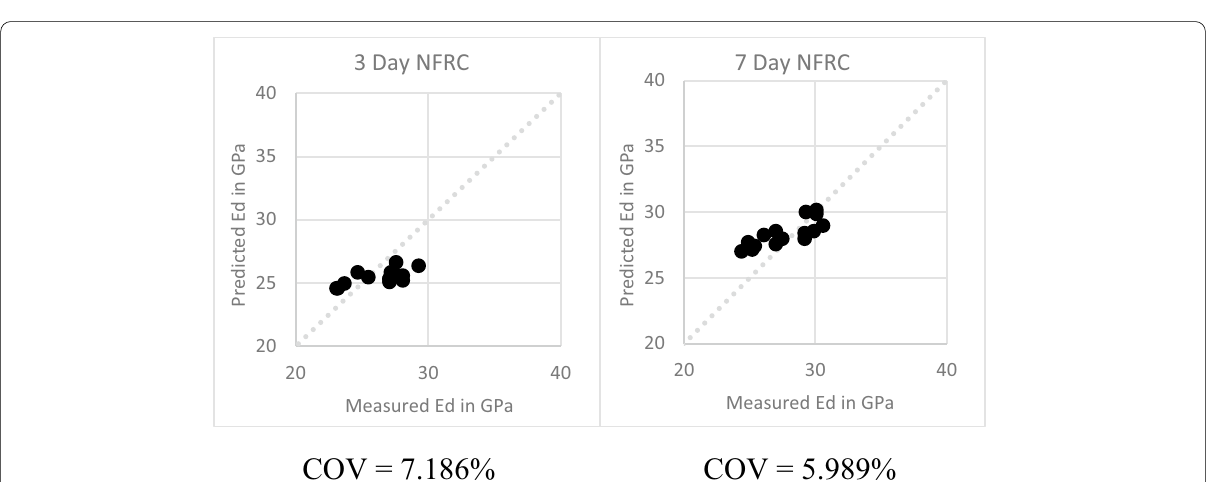
Fig. 6 Correlation between observed Ed and projected Ed for NFRC at early